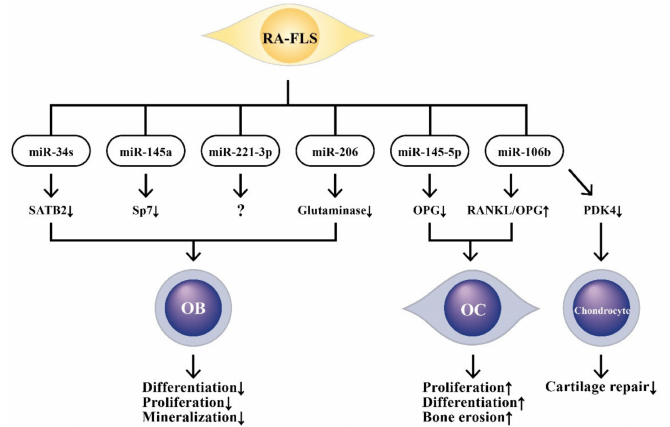
Figure 8. The effects of RA-FLS-released microRNAs (miRs) and their target molecules on the changes in biological behaviors of osteoblasts (OBs), osteoclasts (OCs), and chondrocytes. These aberrant-expressed miRs can target crucial molecules and impair bone regeneration, increase bone destruction, and decrease cartilage repair. SATB2: special AT-rich sequence binding protein 2, Sp7: specificity protein 7, OPG: osteoprotegerin, RANKL: receptor for activator of NF- κ B ligand, PDK4: pyruvate dehydrogenase kinase 4.